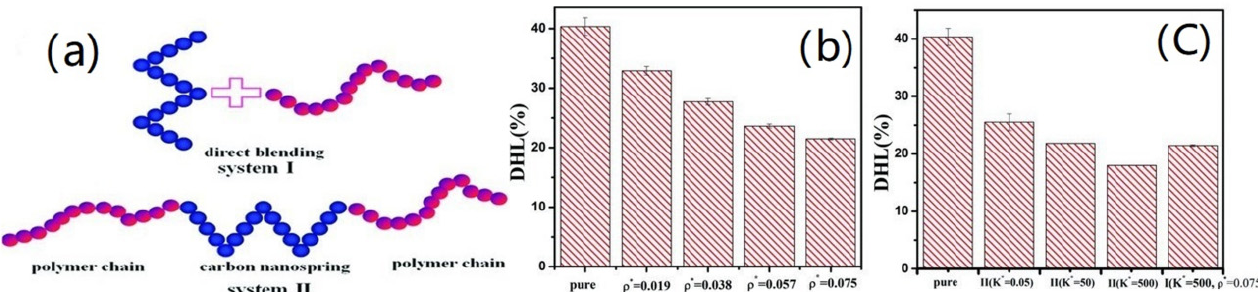
Figure 3. ( a ) Two systems filled with nanosprings. ( b ) Hysteresis loss of system I. ( c ) Hysteresis loss of system II [38]. The dimensionless spring constant is denoted by K* and ρ * represents the dimensionless interfacial chemical coupling